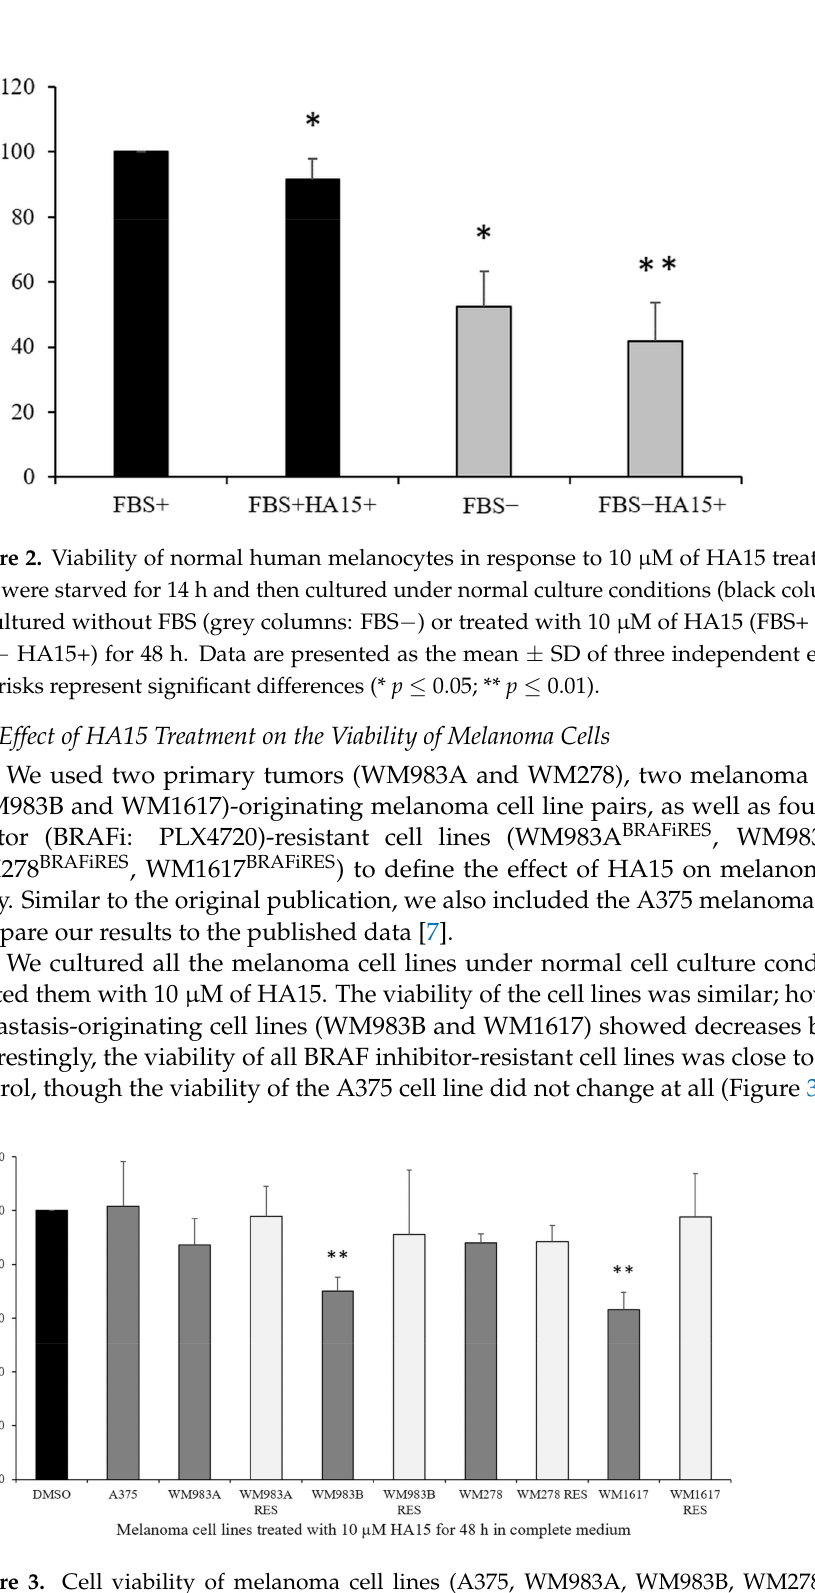
Figure 3. Cell viability of melanoma cell lines (A375, WM983A, WM983B, WM278, WM1617) and their BRAFi-resistant counterparts (WM983A BRAFiRES , WM983B BRAFiRES , WM278 BRAFiRES , WM1617 BRAFiRES ). All the cell lines were treated with 10 µ M of HA15 for 48 h in complete medium. Data represent the mean viability of three independent experiments ( ± SD). Significant differences are indicated by asterisks (** p ≤